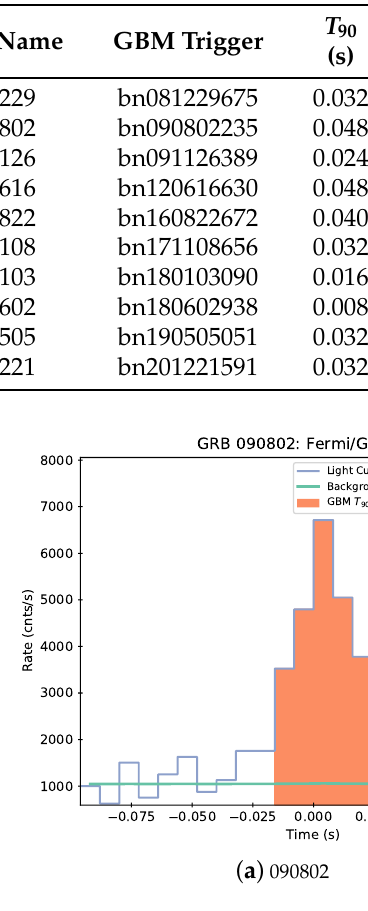
Figure 1. NaI lightcurves of GRB 090802 and GRB 160822. The blue line is the observed lightcurve, the green line is the fitted background line and the orange shadow region is the GBM T 90 duration. The binned time is 0.008